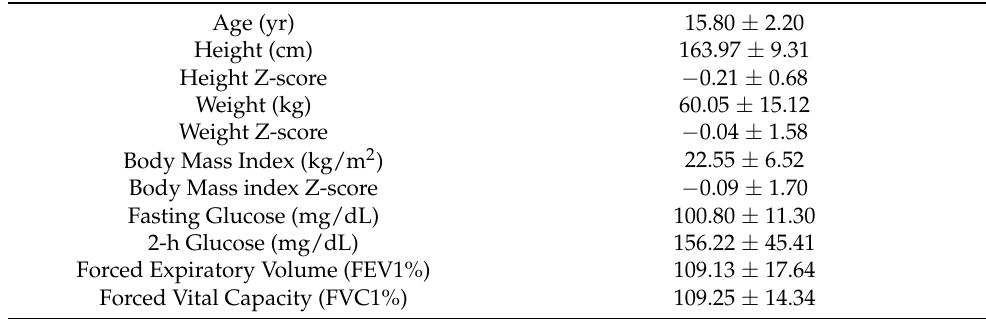
Table 1. Descriptive data.